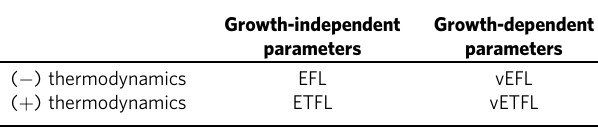
Table 2 Nomenclature of the models used in the study of E. coli